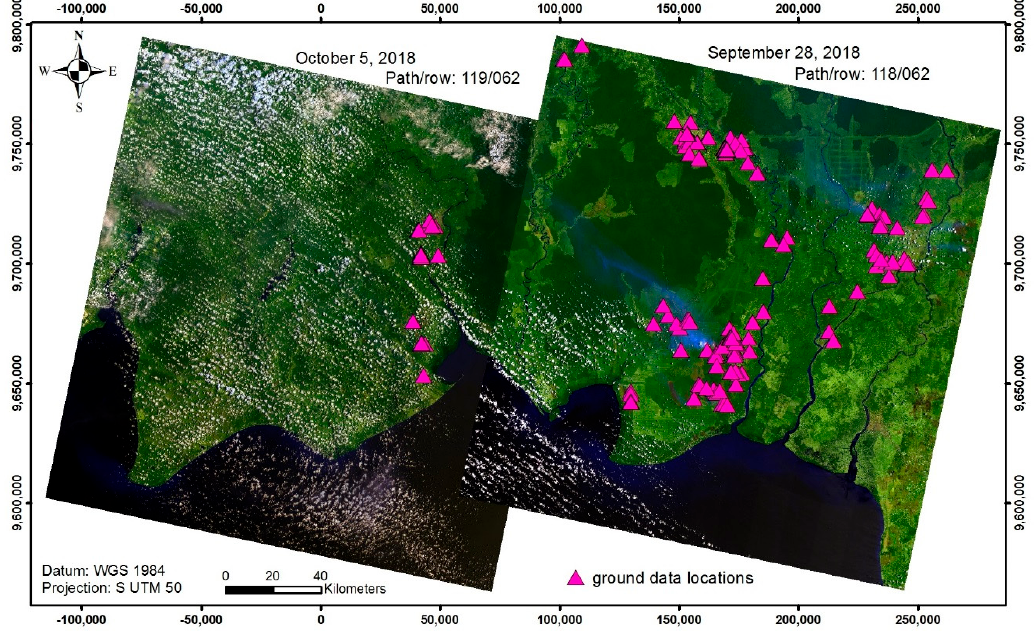
Figure 8. The coverage of ground truth collection in Central Kalimantan (27 September–6 October 2018) overlaid on Landsat-8 images of 28 September 2018 (right) and 5 October 2018 (left). Figure 9 shows a large peatland fire on 28 September 2018, displaying a large group of flaming pixels in yellow tones in the 764 RGB image of Landsat-8 (Figure 9A). Flaming occurs at the fire-front with smouldering and mixture of flaming and smouldering pixels in orange to reddish tones inside the boundary of fire. The result of peatland combustion mapping corresponds to the 764 RGB images of Landsat-8 which were classified into three classes; red for flaming, blue for smouldering, and yellow for the mixture of flaming and smouldering pixels (Figure 9B). Ground truth were collected by local BNPB on the same day (28 September 2018) from a helicopter, because of both the large size of the peat fires and their inaccessibility from the land. The location of ground truth base stations is shown by the magenta triangles. The picture taken from the helicopter in Figure 9C shows the large area of peat fires on the ground. The upper picture was taken from a water bombing helicopter (its shadow is visible in the picture), while the lower picture shows the peatland fires with significant smoke emanating from the ground; this oblique picture was captured from about 2 km distance from the fire.